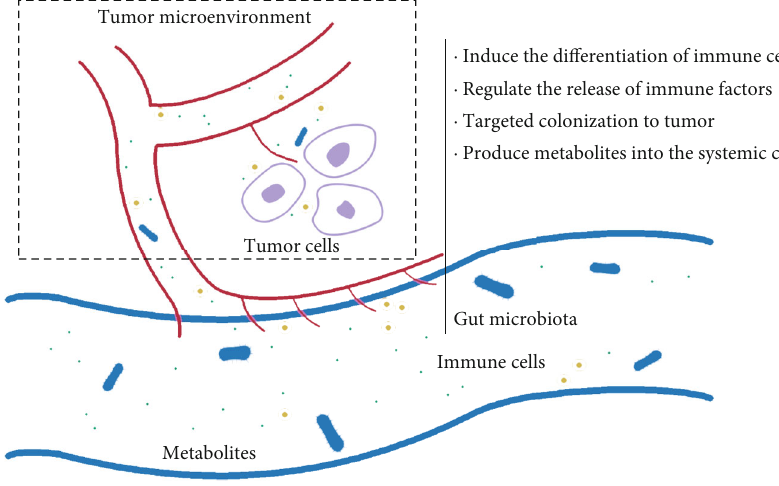
Figure 1: The role of gut microbiota on tumor